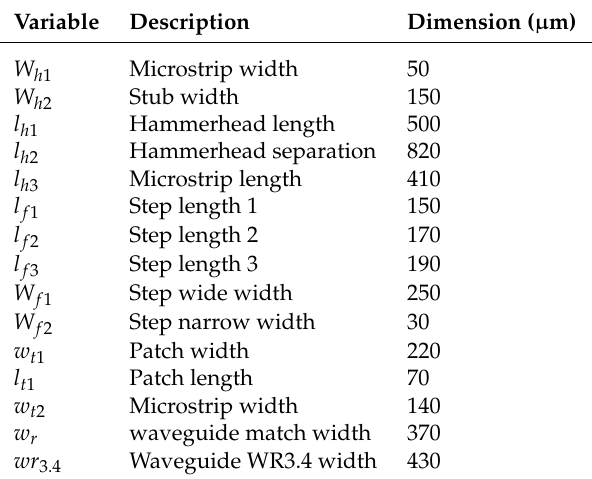
Table 2. Dimensions of the passive circuits of the subharmonic mixer . See Figure 5, for